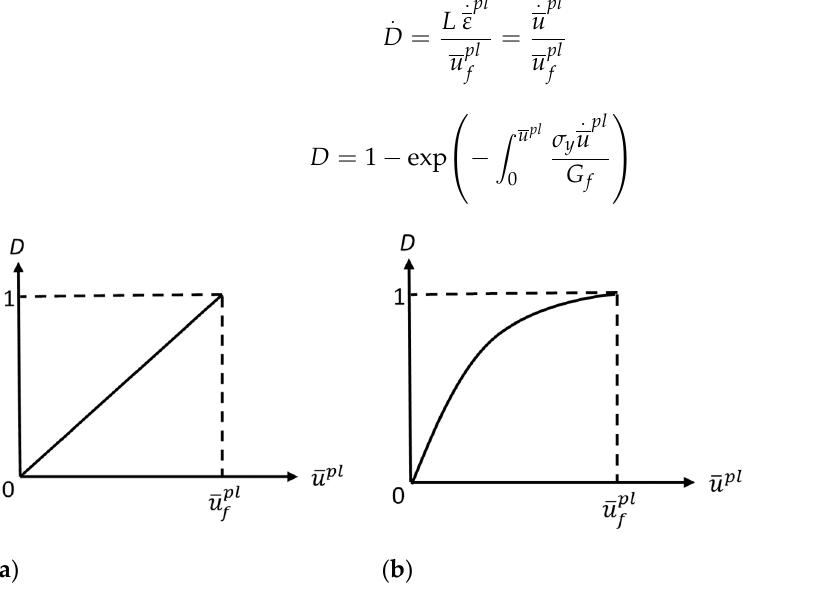
Figure 2. Damage/failure evolution parameter ( D ) in terms of equivalent plastic displacement ( 𝑢(cid:3364) (cid:3043)(cid:3039) ): ( a ) linear damage evolution and ( b ) exponential damage evolution. ( a ) linear damage evolution and ( b ) exponential damage